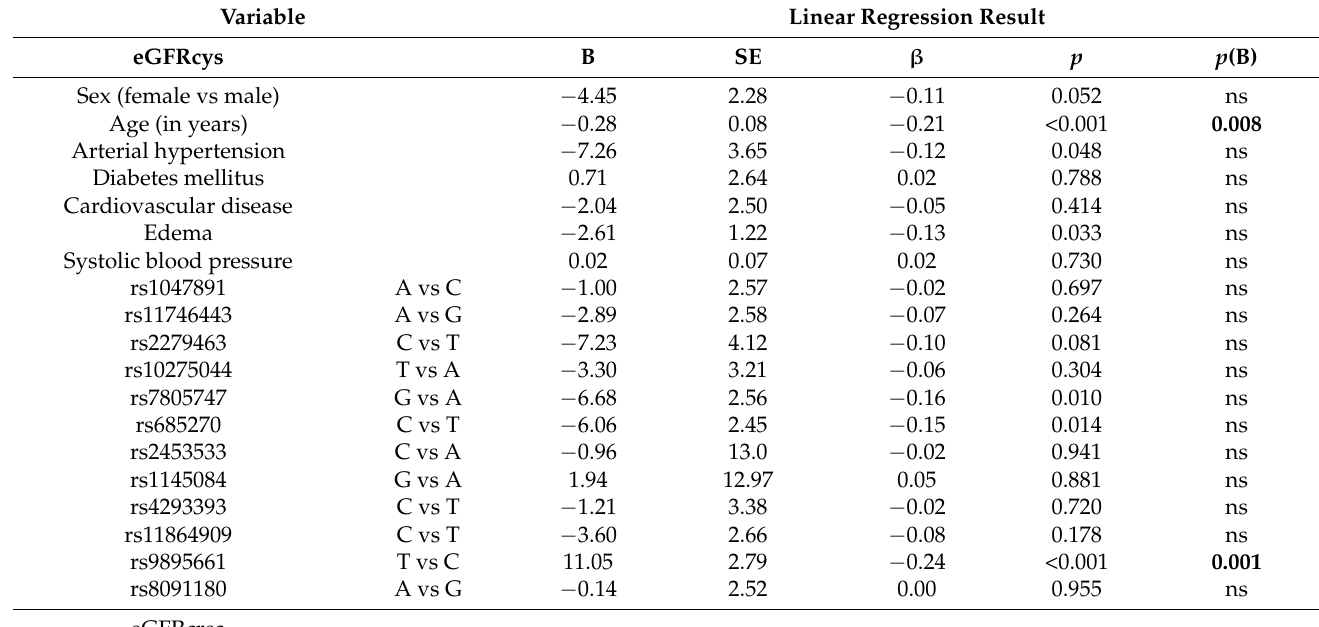
Table 3. Associations with average eGFRcys and eGFRcrea in the dialysis-independent group. Variable Linear Regression